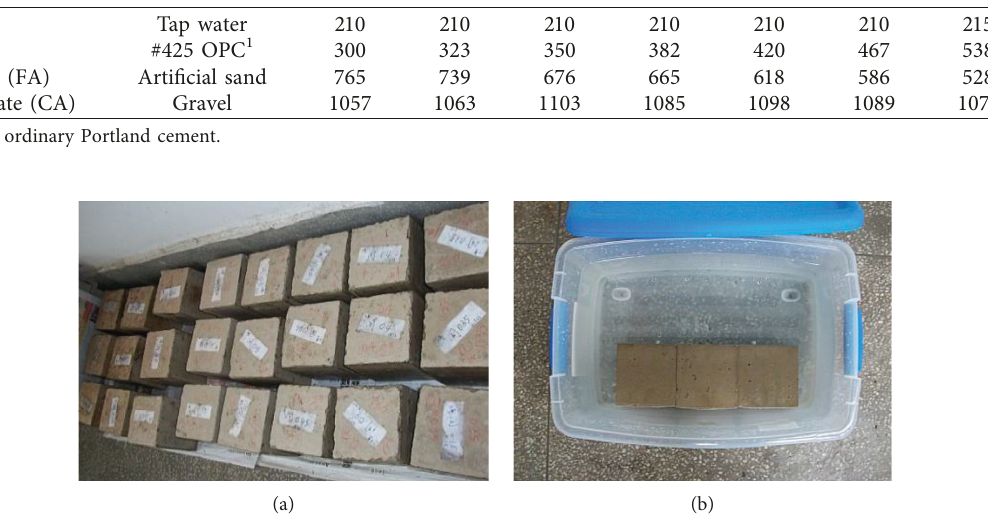
Figure 2: Test layout for sulfuric acid corrosion on concrete: (a) specimens and (b) soaking pool.